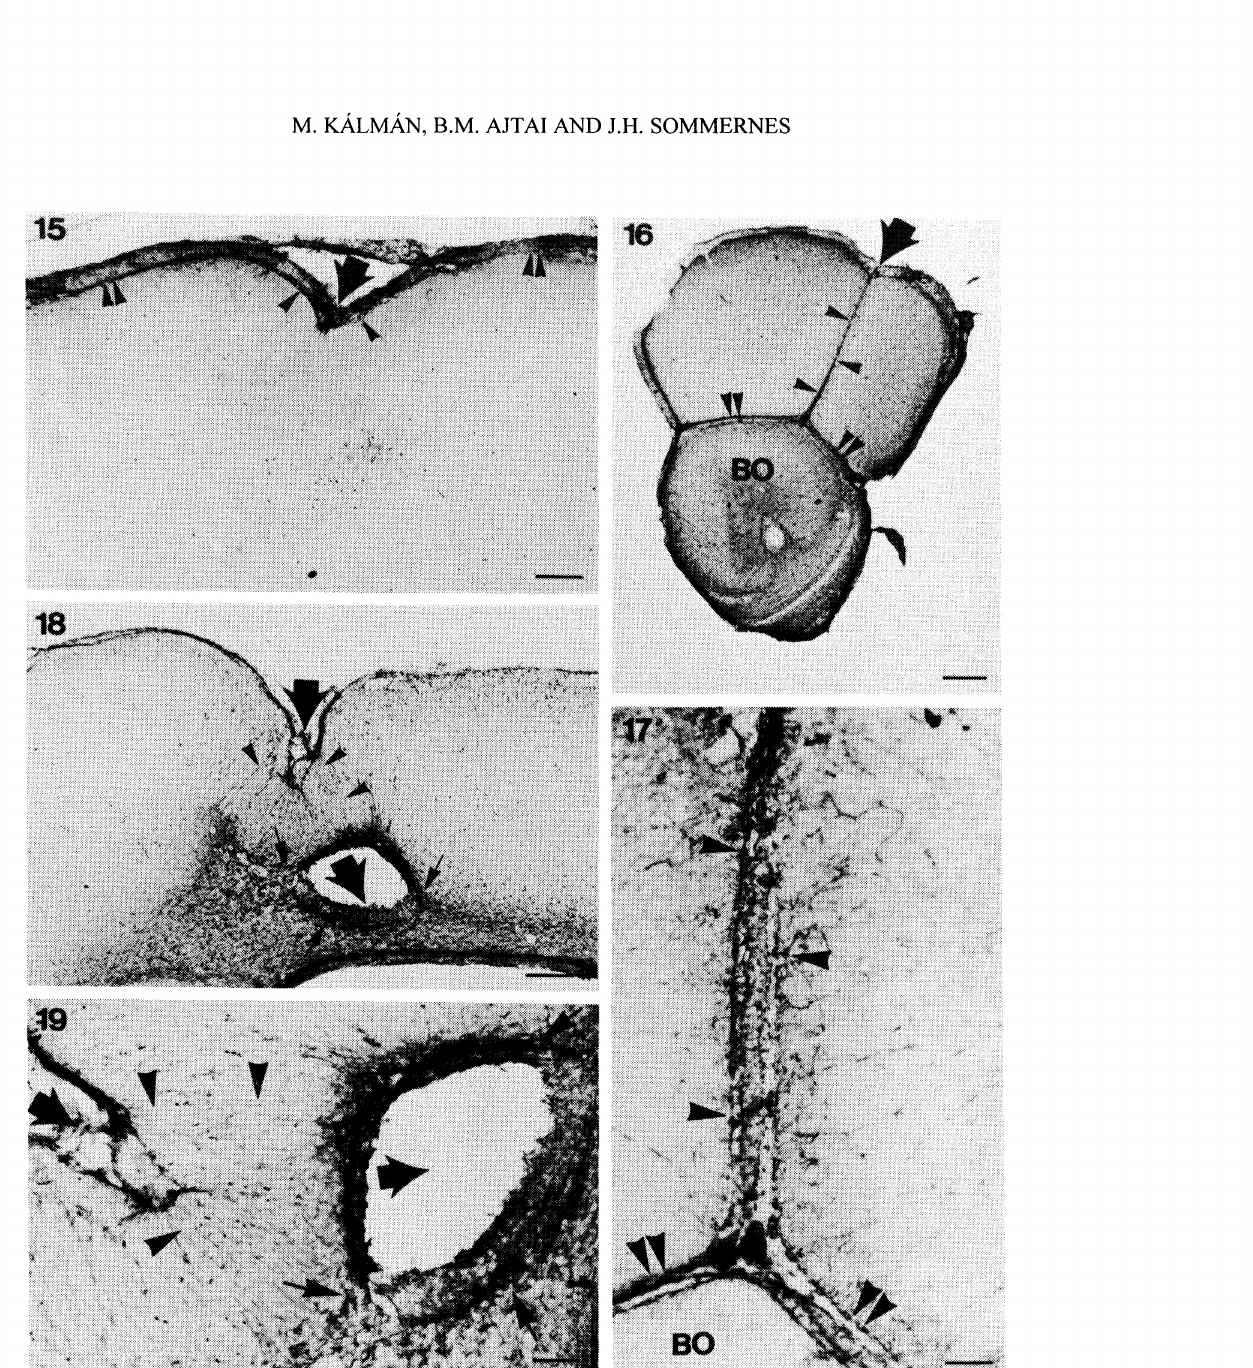
Figs. 15-19: GFAP immunostaining of severe-type glial reactions. (15) P0 lesion, post-op d-7. Lesion site (thick arrow) is recognizable as an invagination of the cortex. The surface of the lesion (arrowheads) is similar to the intact surface of the cortex (double arrowhead). Bar 150 gm. (16) P0 lesion, post-op d-8. The lesion (thick arrow) divides the frontal pole of the telencephalon. BO-olfactory bulb. Bar 500 gm. (17) P0 lesion, post-op d-8. Enlarged detail of Fig. 16. No reactive glia are visible, the glia along the surface of the lesion (arrow-heads) are similar to that seen below the intact surface of the cortex (double arrow-heads). BO-olfactory bulb. Bar 80 gm. (18) PI lesion, post-op d-10. Lesion (thick arrow) is recognizable as an impression of the cortex and a tissue defect near the corpus callosum. Glial reaction can be observed only around the latter one (arrows). Note the GFAP-positive radial glial fibers around the cortical invagination (arrowheads). This specimen seems to be a borderline case between the reaction types shown in Figs 3 to 5 and those in Figs 15 to 17. Bar 250 lam. (19) Enlarged part of Fig. 18 (see legend to Fig. 18). Bar- 100